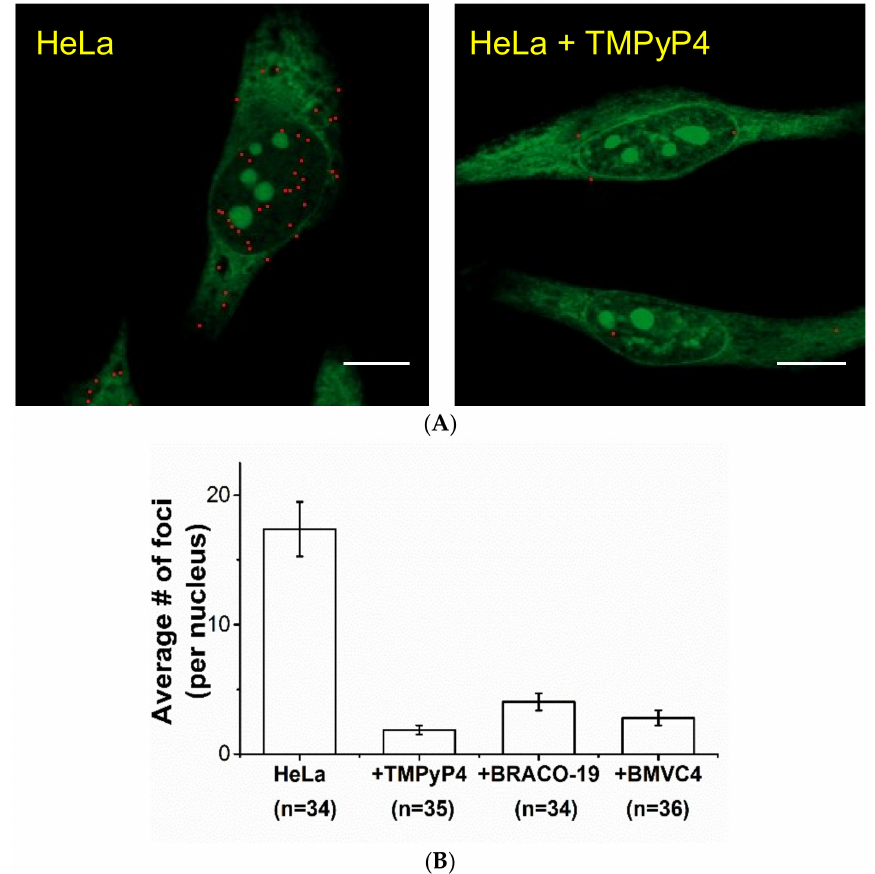
Figure 3. The effect of other G4 ligands on G4 foci in cells. ( A ) The analyzed binary images of o -BMVC foci in HeLa cancer cells ( left ) and HeLa cancer cells incubated with 10 µ M of TMPyP4 overnight ( right